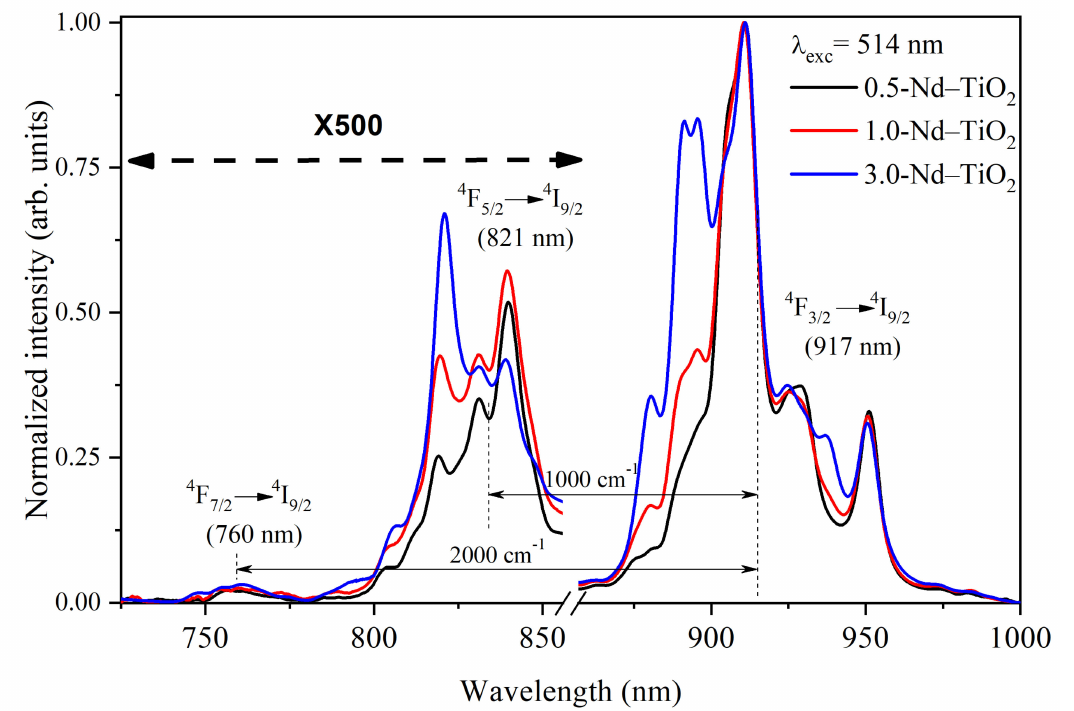
Figure 5. Normalized near-infrared photoluminescence spectra of x -Nd–TiO 2 ( x = 0.5, 1.0 and 3.0 wt.%) nanoparticles, excitation at 514 nm. The intensity of the 4 F 7/2 → 4 I 9/2 and 4 F 5/2 → 4 I 9/2 transitions were multiplied by a factor of 500 for better